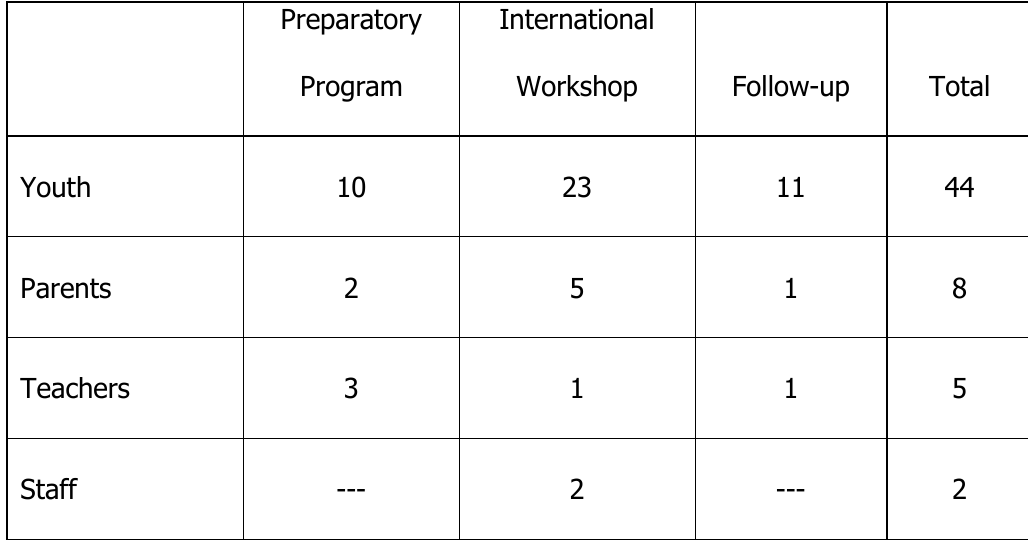
Summary of Case Study Interviews/Focus